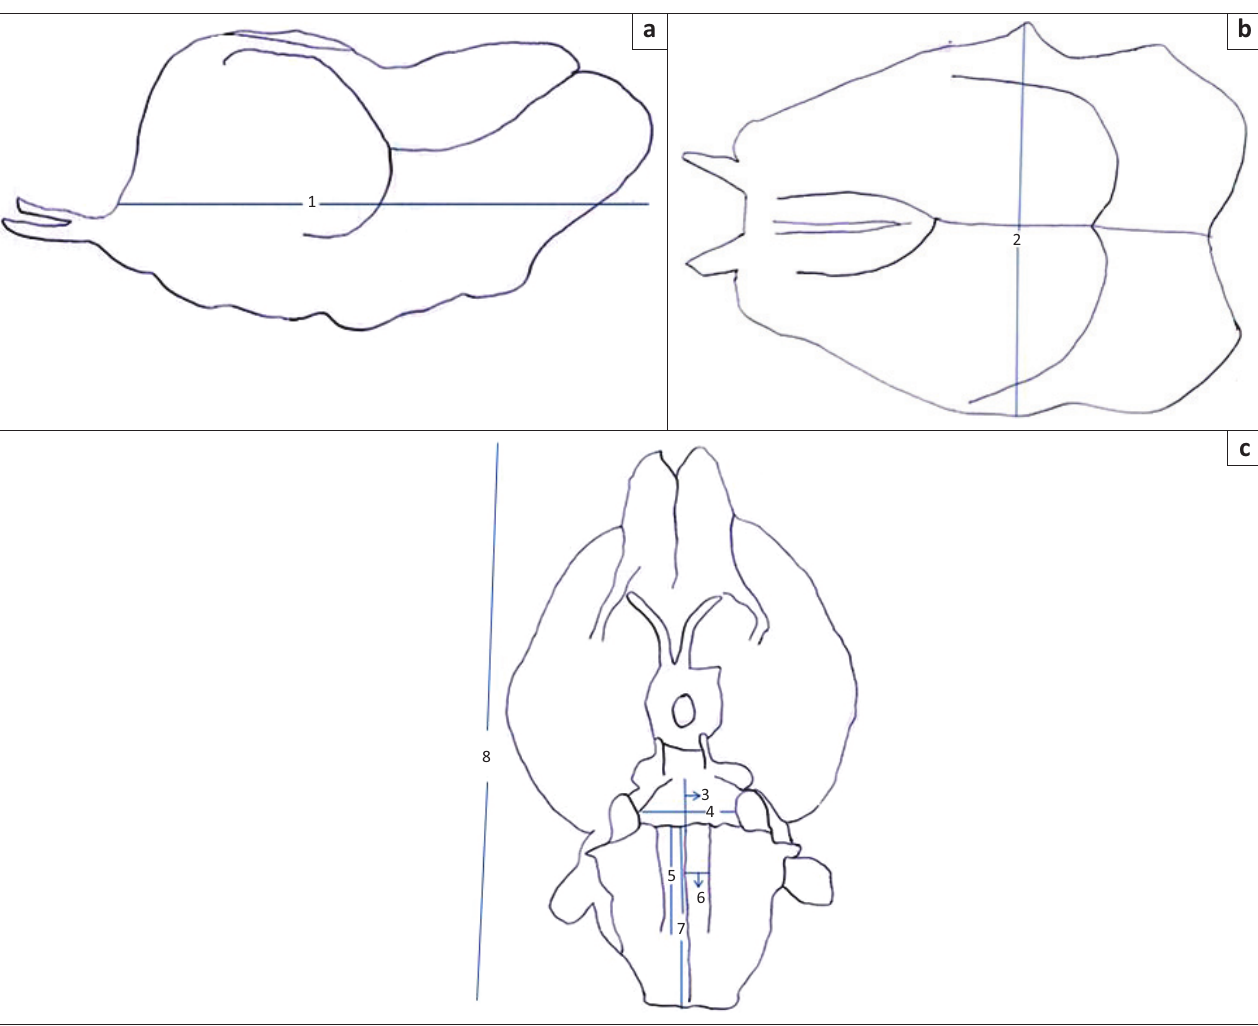
TABLE 2: Age-specific allometry of the pons in the African grasscutter (mean ± SEM). Pons parameter